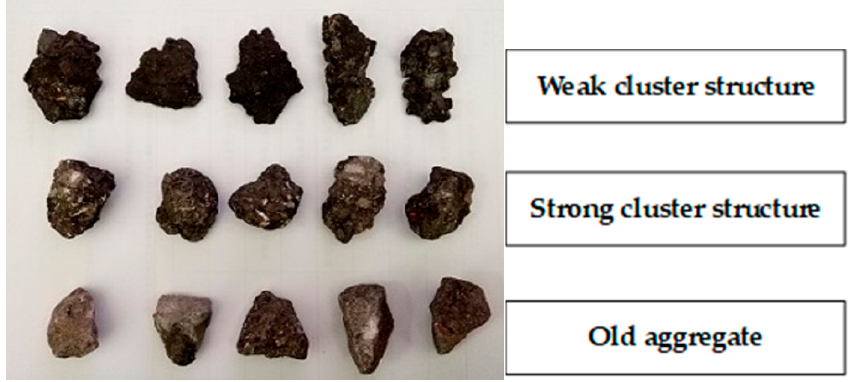
Figure 8. Three Different Cluster Structures of RAP.